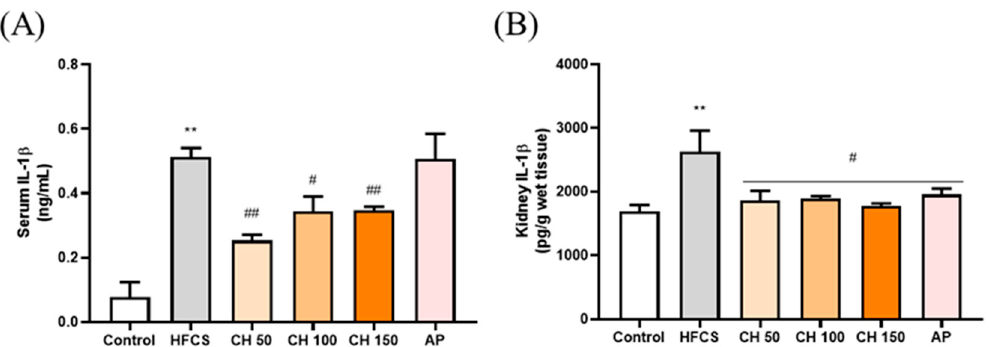
Figure 5. Effects of chrysin on pro-inflammatory cytokine ( A ) IL-1 β in serum and ( B ) IL-1 β in renal tissues of fructose- induced hyperuricemic rats. C: control; HFCS: high-fructose corn syrup group (10% high-fructose corn syrup solution); AP: Allopurinol (10 mg/kg bw); CH 50: chrysin (50 mg/kg bw); CH 100: chrysin (100 mg/kg bw); CH 150: chrysin (150 mg/kg bw). Data are represented as mean ± SEM ( n = 4–6 per group). ** p < 0.01 versus the control group. # p < 0.05, ## p < 0.01 versus the HFCS group.